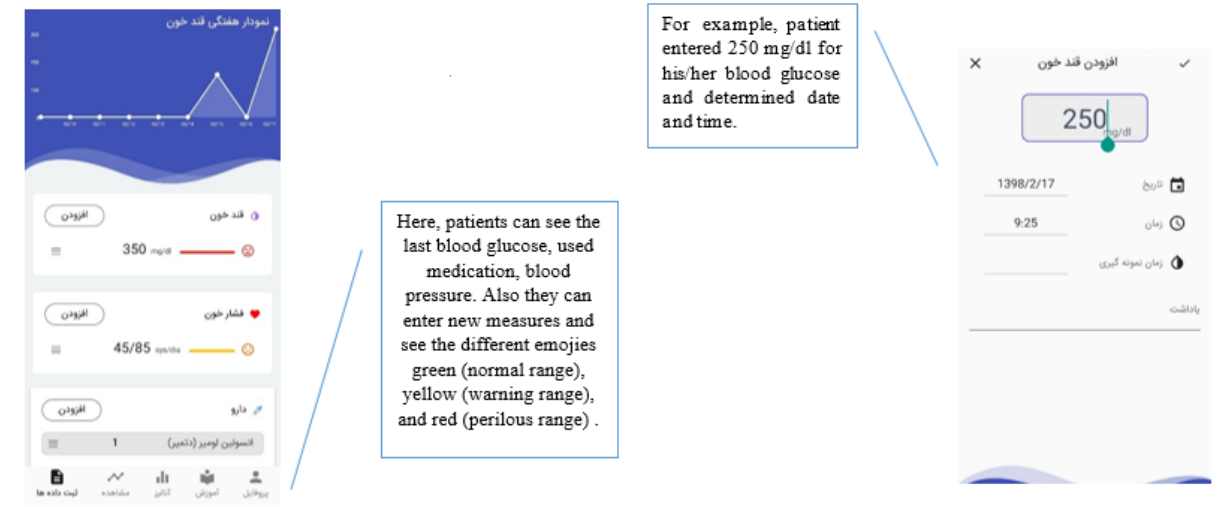
Figure 3. Logbook module where participants can enter their clinical data. This screen shows that the blood glucose level was entered and saved on a specific day and